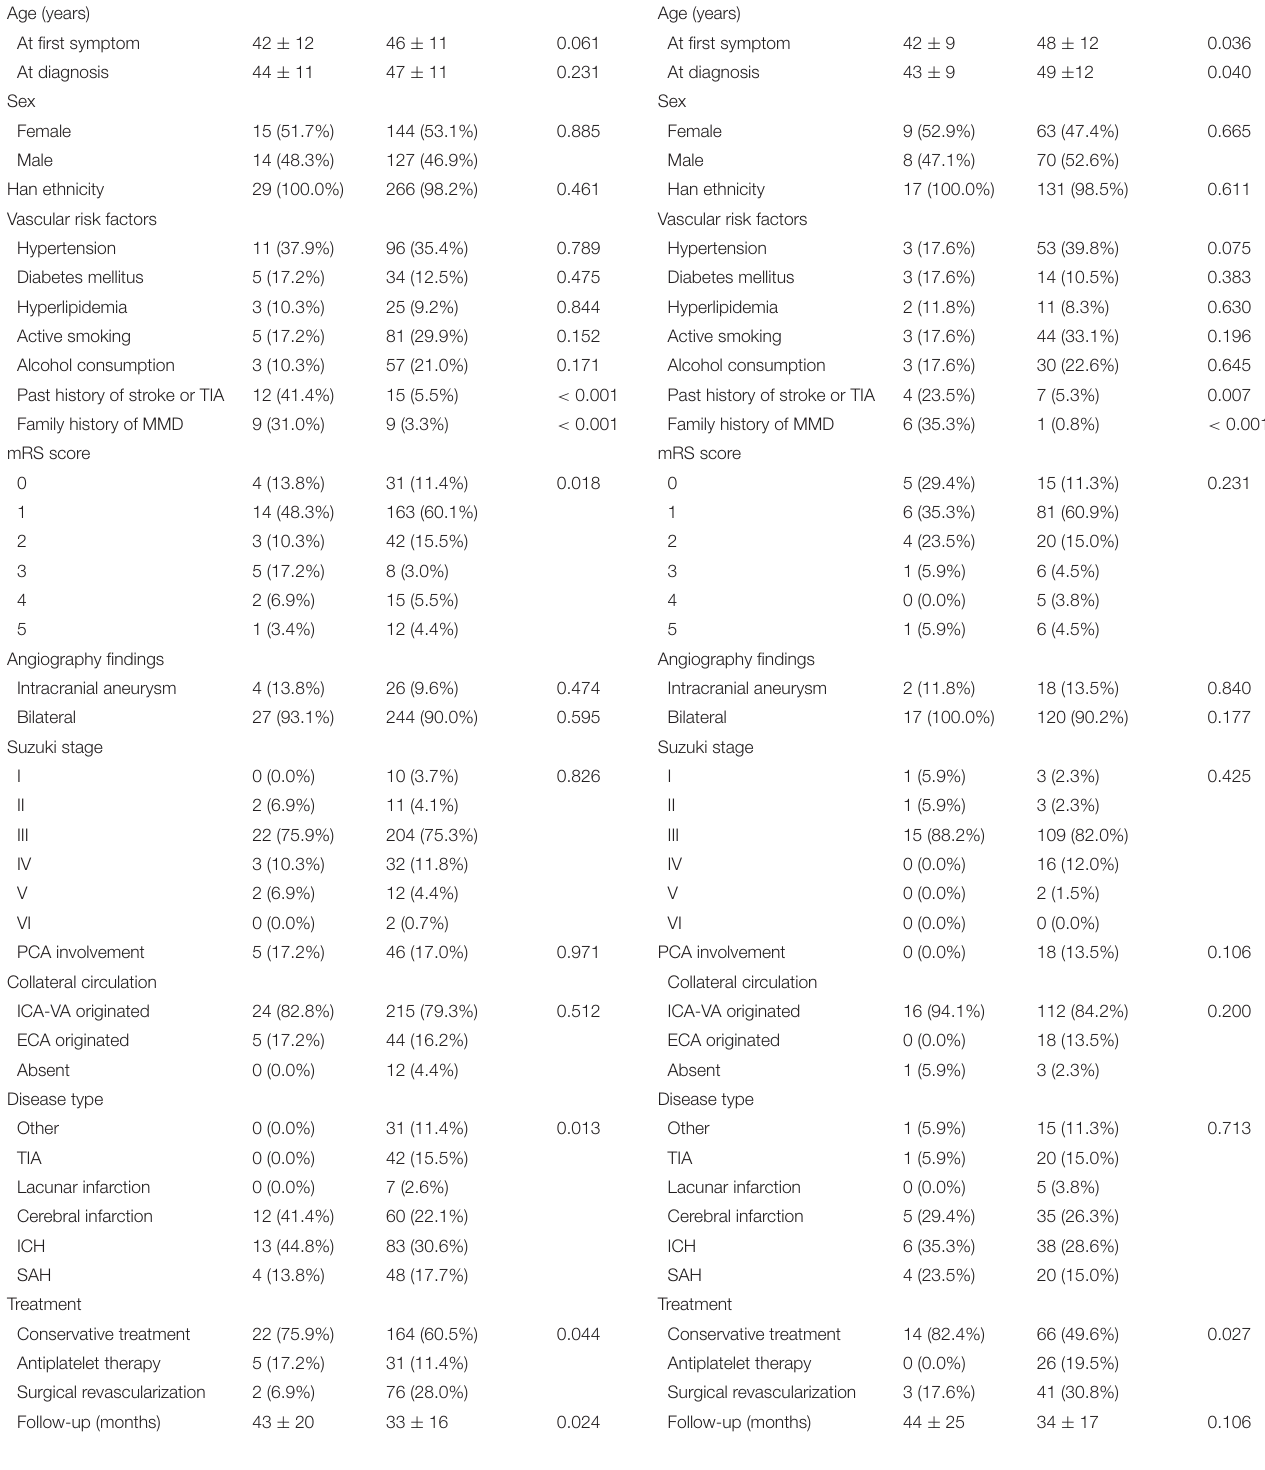
TABLE 4 | Comparison of demographic and clinical characteristics between patients with and without future stroke events in the test group.